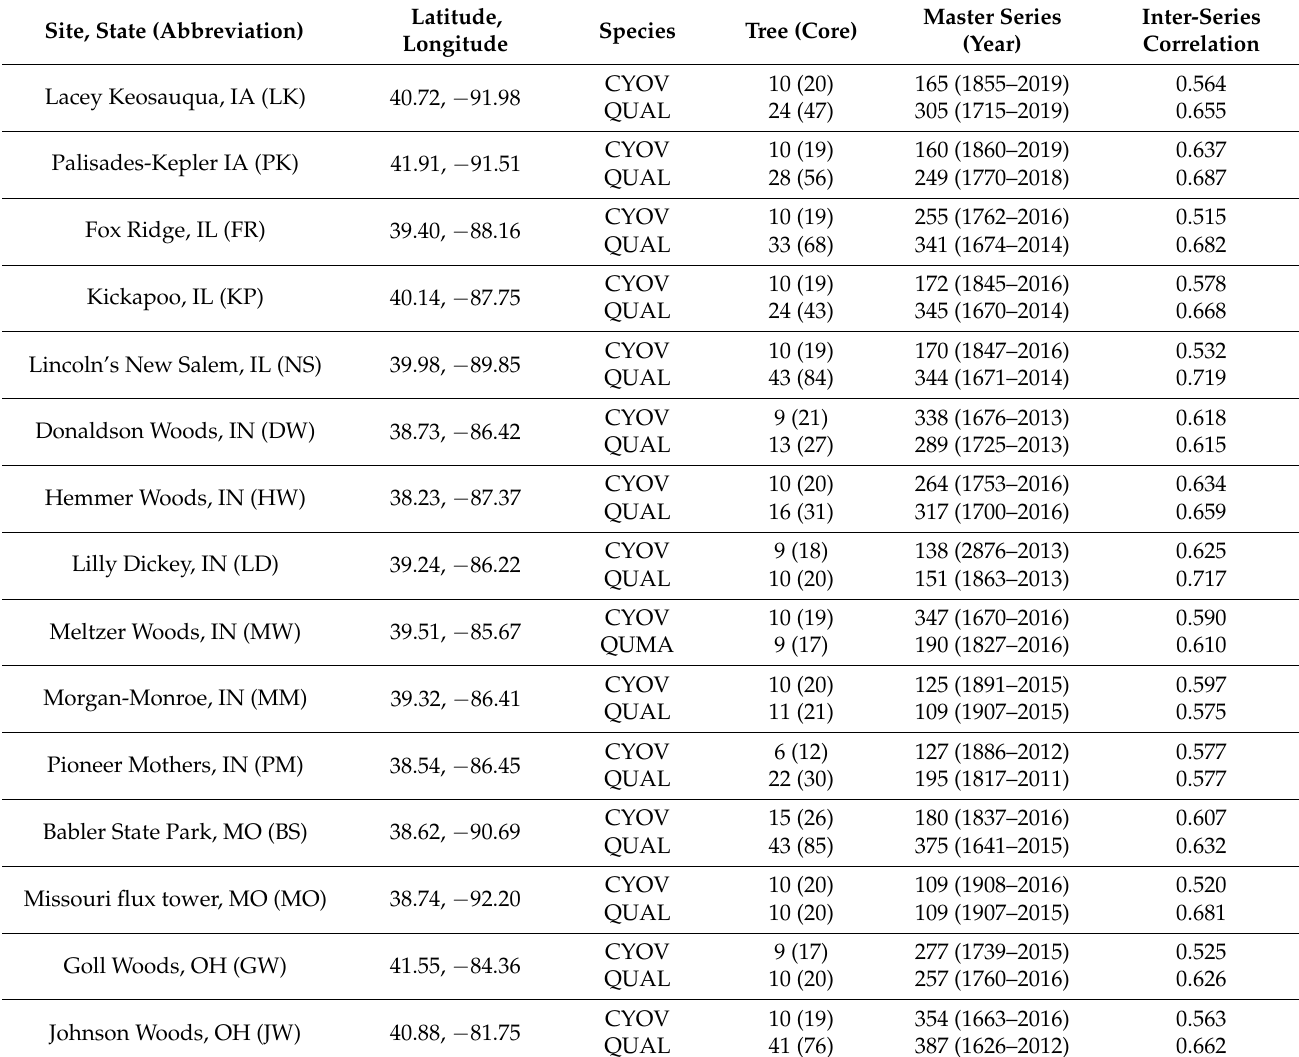
Table 1. Summary of co-occurring Carya ovata (CYOV), Quercus alba (QUAL), and Quercus macrocarpa (QUMA) at 15